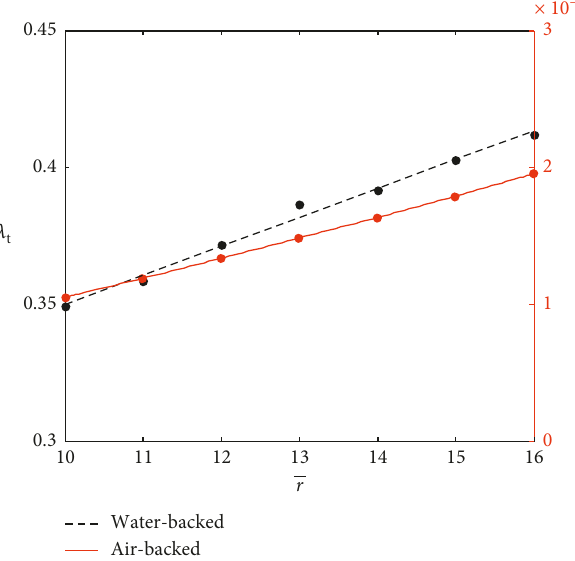
Figure 19: The transmission coefficients of peak pressure for different detonation distances. The water-backed case is plotted in the left axis, and the air-backed case is plotted in the right